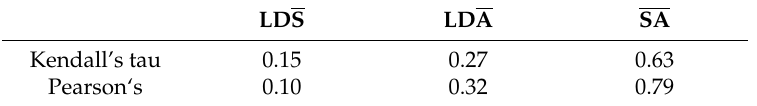
Table 4. Kendall’s tau and Pearson’s correlations between drought characteristics LD, S, and A. LDS LDA SA Kendall’s tau 0.15